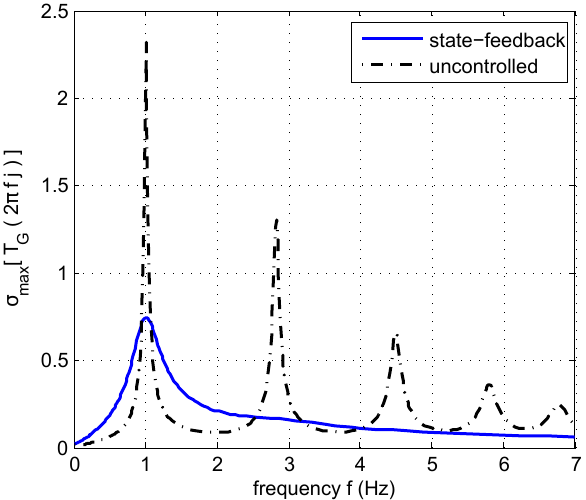
Figure 6: Maximum singular values for the closed-loop pulse transfer function T (2 πfj ) (solid blue (cid:101) G s line) and the open-loop transfer function T (2 πfj ) (dash-dotted black line)